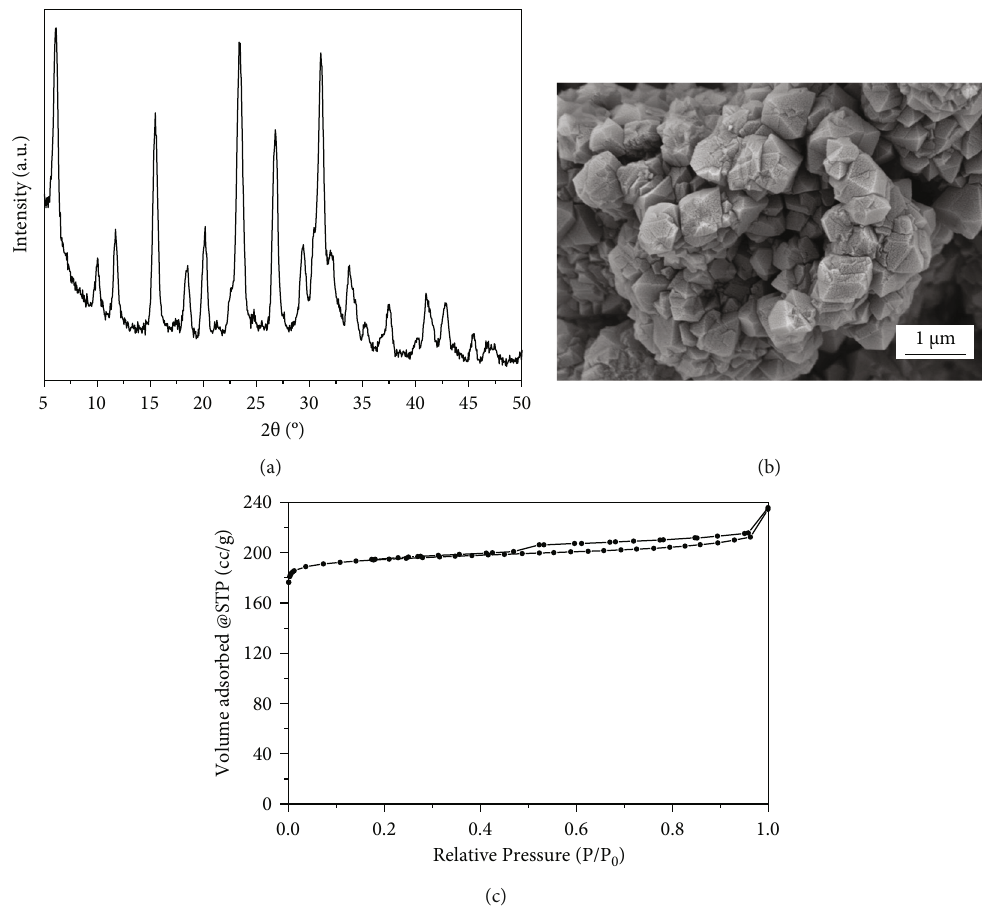
Figure 1: Textural properties of RHA silica-based zeolite FAU: (a) XRD pattern, (b) SEM image, and (c) N